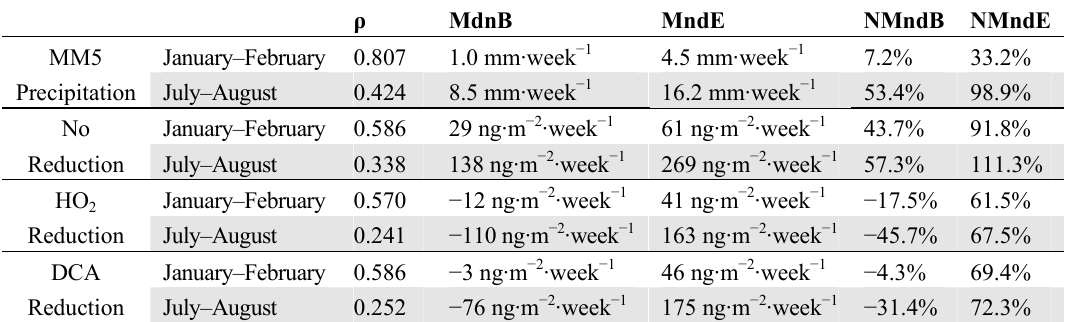
Table 1. Spearman’s rank correlation coefficient ( ρ ), median bias (MdnB), median error (MdnE), normalized median bias (NMdnB), and normalized median error (NMdnE) of the MM5 modeled precipitation and CMAQ Hg wet deposition for total wet deposition, weekly (n = 372 in January–February, n = 420 in July–August) compared to MDN